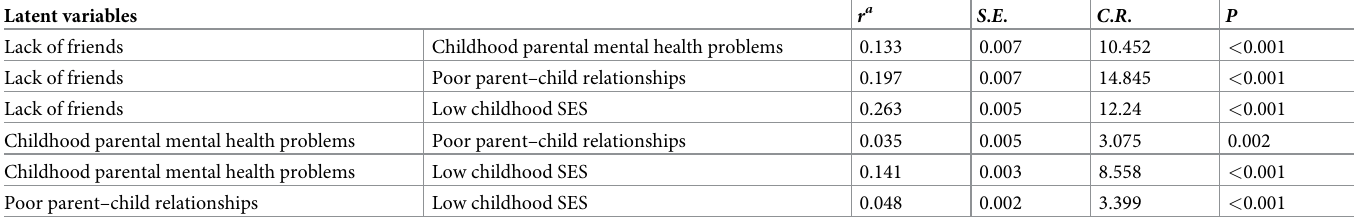
Table 4. Correlations of four latent variables of childhood adversities ( N =